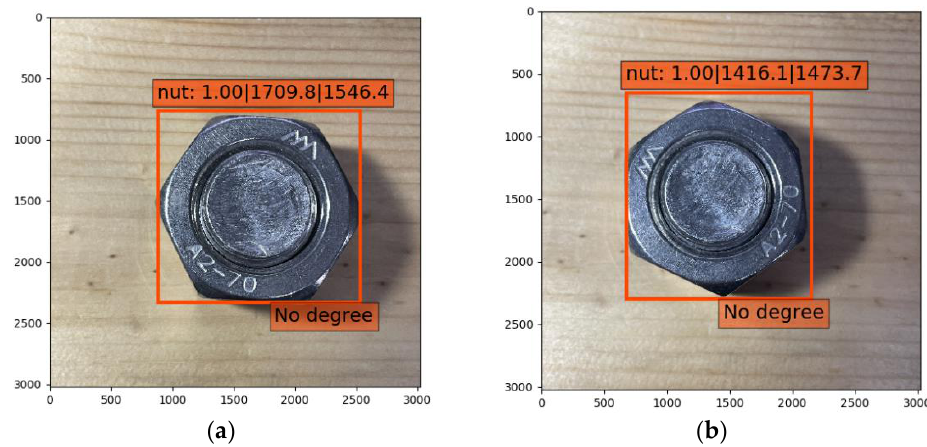
Figure 10. Identification results of scheme A: ( a ) initial state of a nut; ( b ) state of a nut after rota- tion .